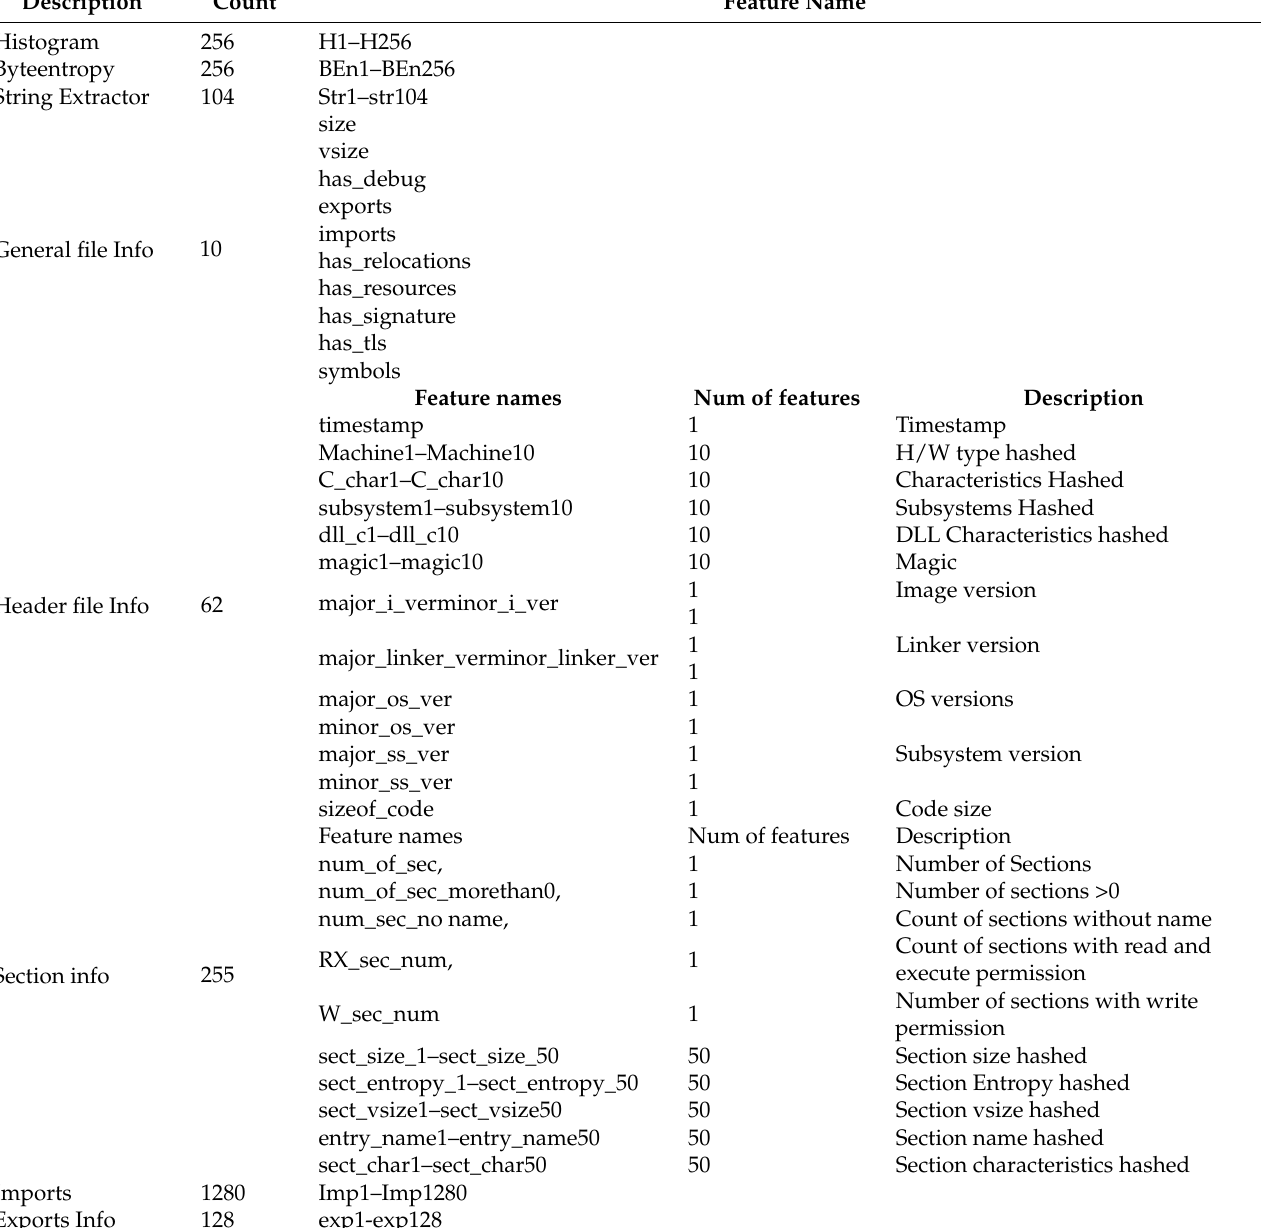
Table 4. Features names in the dataset